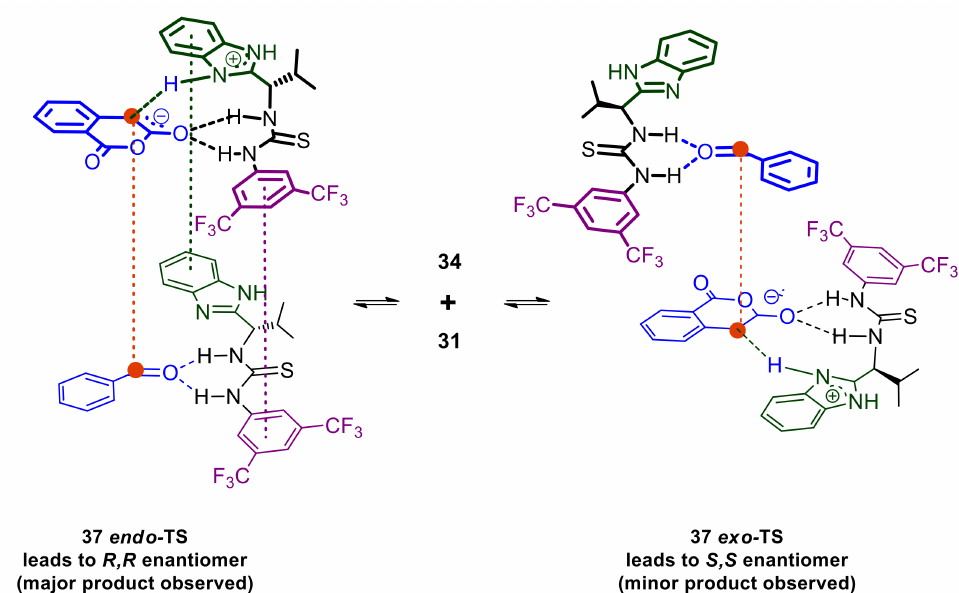
Scheme 14. Equilibration between cis and trans aldehyde-catalyst complexes leading to competing endo and exo transition states and ultimately to opposite